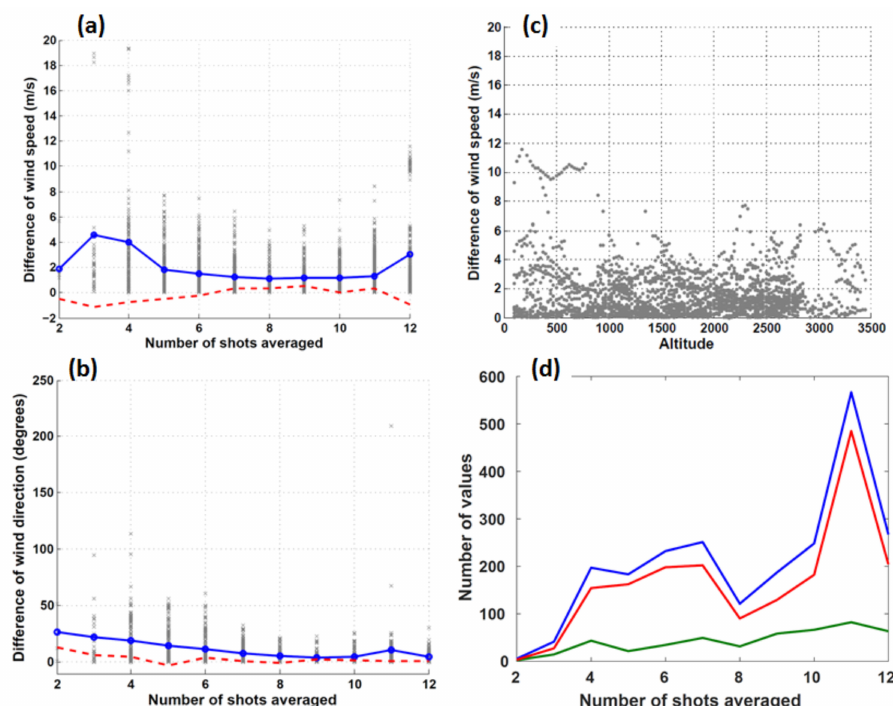
Figure 3. ( a ) The absolute difference between collocated lidar and dropsonde wind speeds (gray x symbols) as a function of number of line-of-sight (LOS) shots collected to determine the measurement. The standard deviation (solid blue) and bias (dashed red) of these differences are shown; ( b ) Same as ( a ), but with ADWL and dropsonde wind directions outside of the tropical cyclone (TC) center; ( c ) The absolute difference between collocated lidar and dropsonde wind speeds with 5 or more LOS shots as a function of altitude (m); ( d ) Line graph of the number of observation comparisons for the wind speeds (blue), wind directions outside the TC center (red), and wind directions in the TC center (green) as a function of number of LOS shots collected to determine the